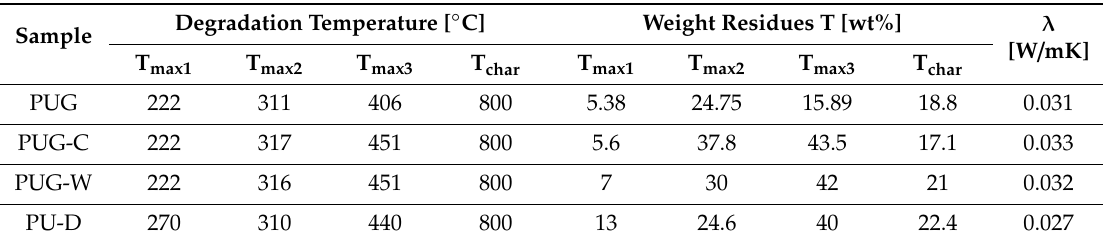
Table 4. Thermal properties form TGA and thermal conductivity of produced polyurethane foams.